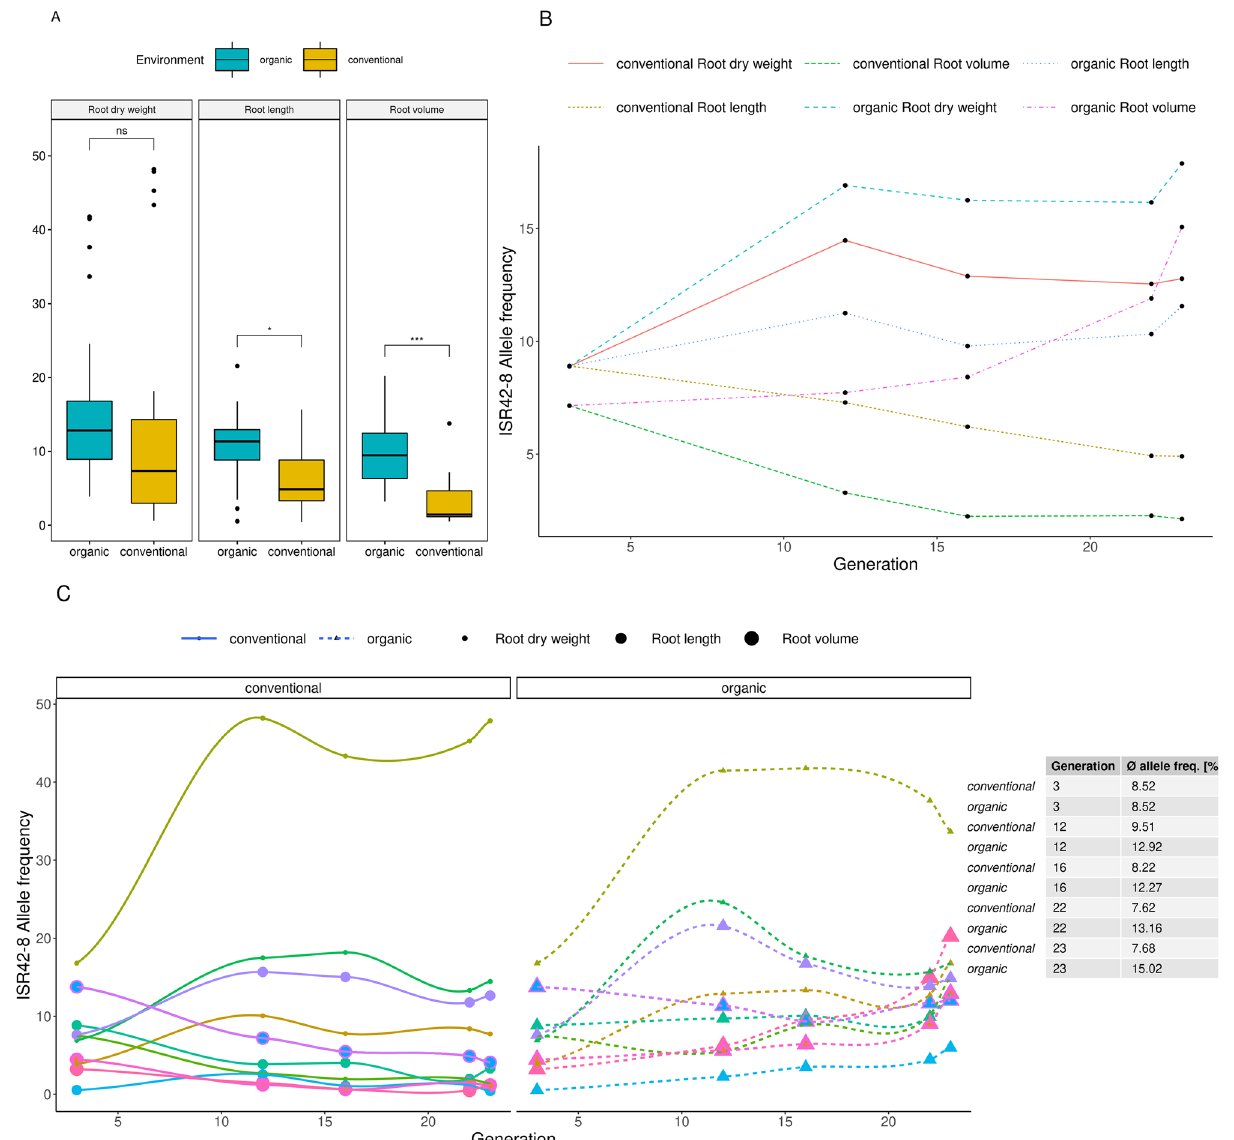
Figure 6. The allele frequency pattern dissection of 18 selected QTL loci related to root architecture traits for both organic and conventional populations in 5 generations (F3, F12, F16, F22, F23). Genomic data derived from Schneider et al. (2021). ( A ) Boxplot of the ISR42-8 allele frequencies for the trait categories root dry weight, root length, and root volume. Stars indicate the significance level of adjusted p values (Bonferroni adjustment) between the environments. The data of all generations are included in this significance test. ( B ) Line plot showing the development of the ISR42-8 allele frequency for the same three categories, separated by the environments across the generations. ( C ) similar to B, but showing the evolution of the ISR42-8 allele frequency across the generations for each QTL locus, separately. Table—indicates the median allele frequency across all 18 QTL loci generation and environmentally